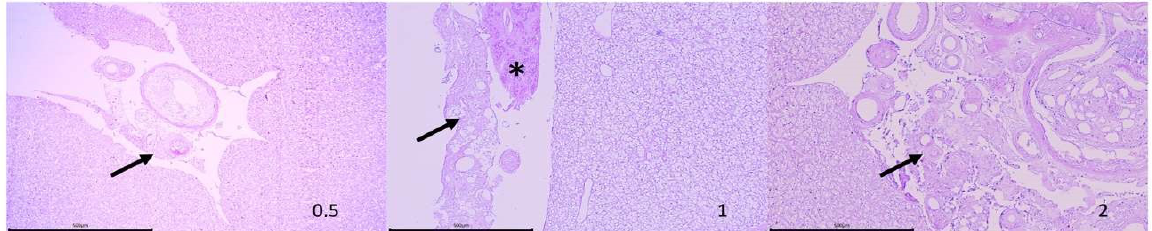
Figure 2. High-power photographs (40×) of liver sections showing a variable incidence of perivisceral granulomatous reaction (arrows). Acinar cells of the exocrine pancreas are indicated with an asterisk (*) and the histological score corresponding to this specific feature is indicated in the lower right corner of each section. Staining: haematoxylin and eosin. Scale bar 100 μM.